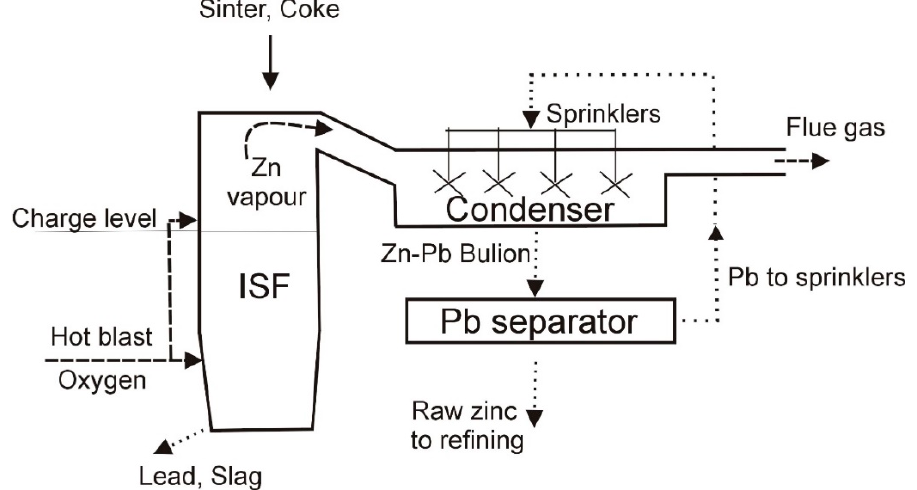
Figure 1. The ISF working diagram.